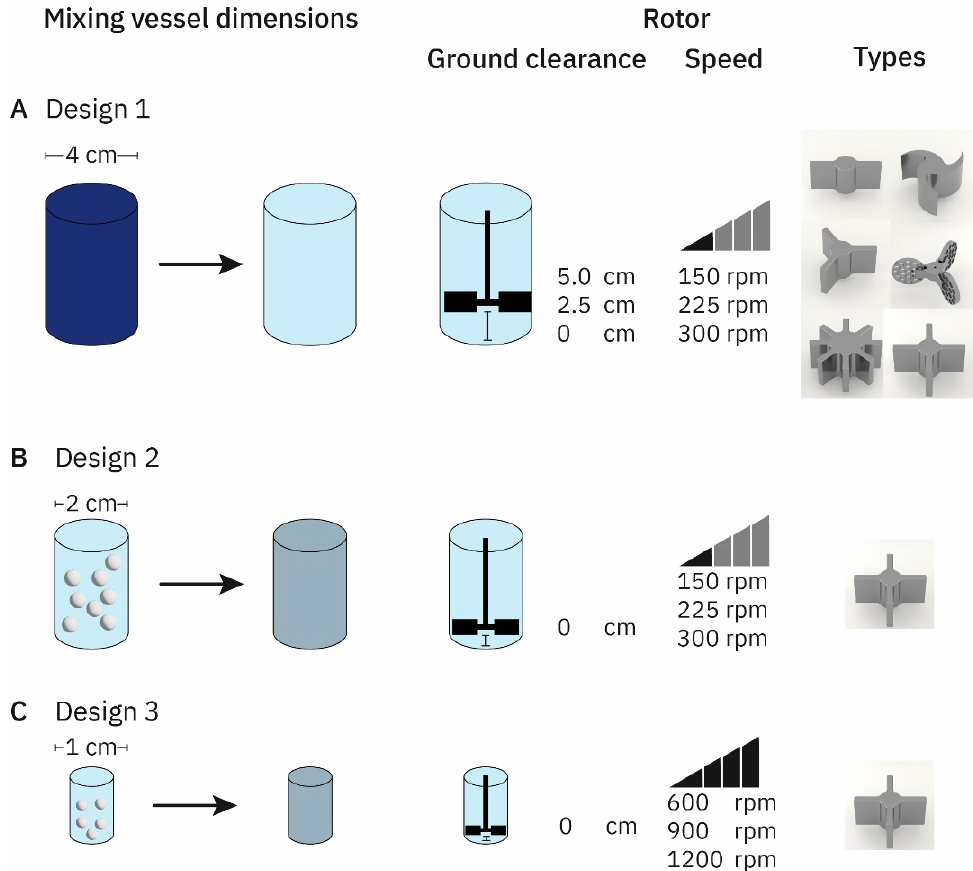
Figure 1. ( A ) Setup for the discoloration assay using a mixing vessel with an internal diameter of 4 cm. The stirrer operated at a ground clearance levels between 0 cm and 5 cm and at a rotational speed of 150 to 300 rpm. Six different types of rotors were compared. ( B ) Conductometric setup for a multi-dose autoinjector surrogate. The four-blade rotor geometry was selected for these designs. The stirrer operated at the bottom of the t mixing vessel at rotational speed ranging between 150 rpm and 300 rpm. ( C ) Conductometric setup for a single-dose autoinjector with an internal diameter of 1 cm. The four-blade rotor was positioned at the bottom and was operated at rotational speed between 600 rpm and 1200 rpm.